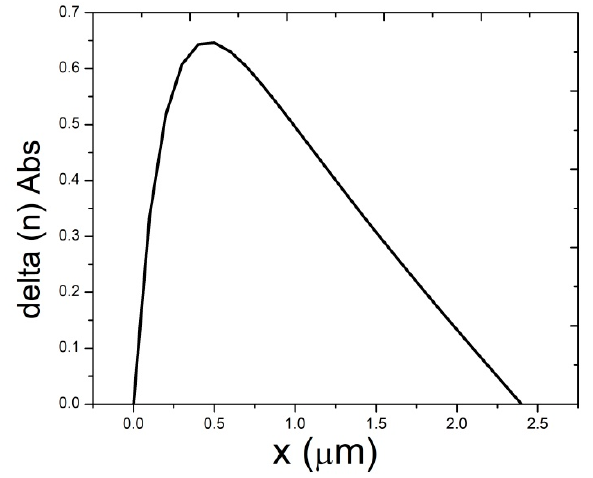
Figure 3. Individual numerical item of the general solution versus x. x is defined as any position in the neutral region.